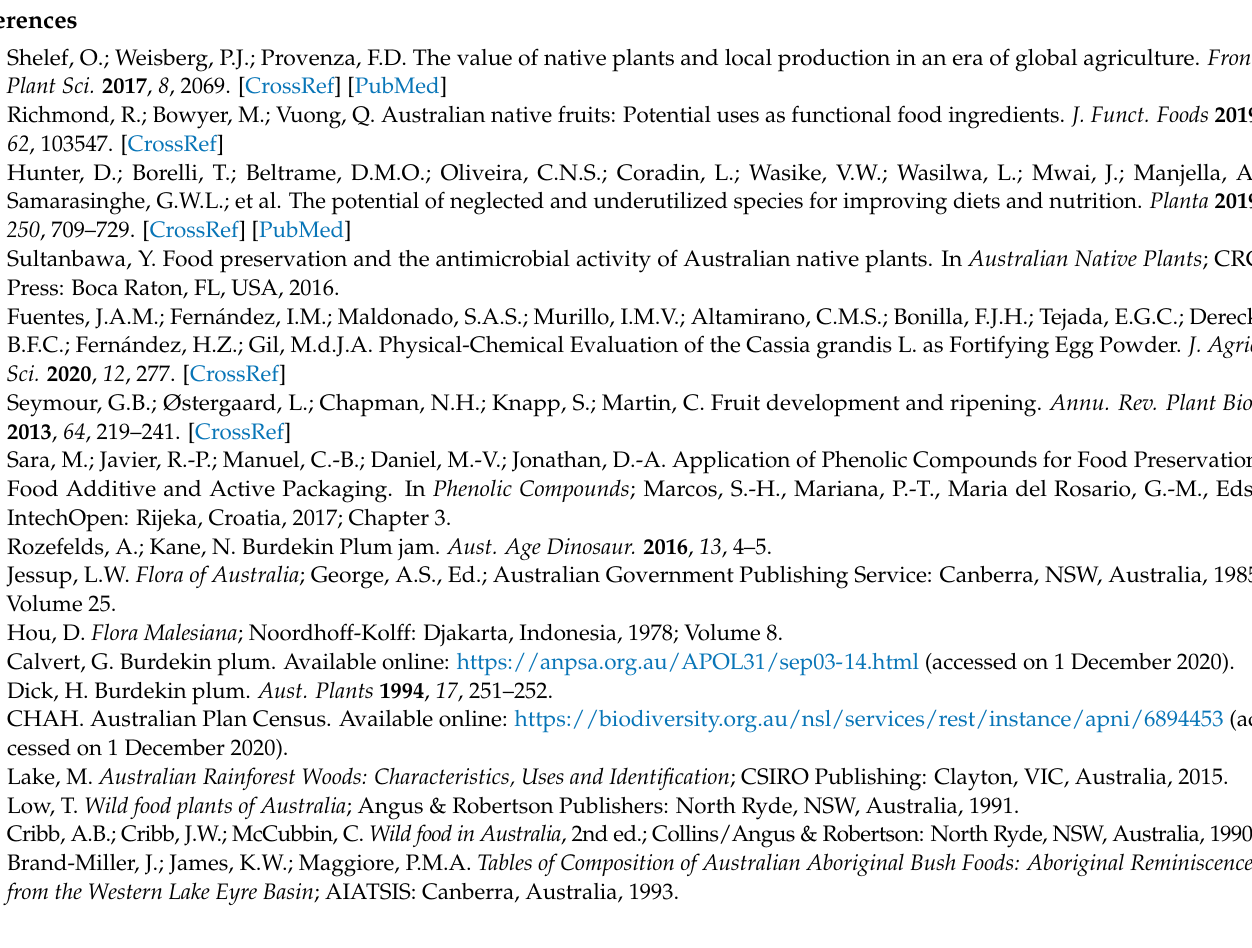
Figure S3: Experimental design; (TSS: total soluble solids, TA: titratable acidity). Reference [129] are cited in the supplementary